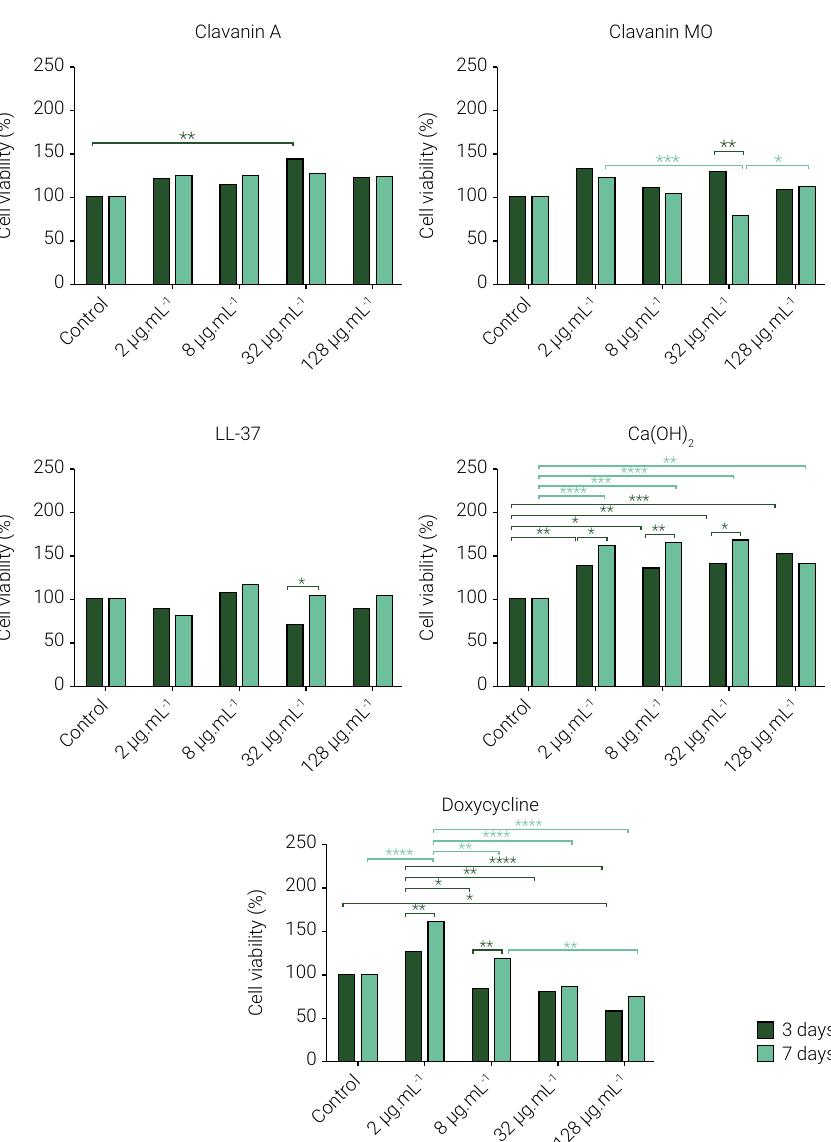
Figure 1. Clavanin A, clavanin MO, LL-37, Ca(OH) and doxycycline cytotoxicity at 2, 8, 32 and 128 μg.mL -1 2 on 2.5x10 3 RAW cells, after 3 and 7 days, by MTT assay. Cultures were stimulated with 100 ng.mL -1 of rRANKL. Cell viability was represented by percentage. Control group was represented by 2.5x10 3 RAW cells stimulated with 100ng.mL -1 of rRANKL and considered 100% of cell viability. All experiments were done in technical and biological triplicates. Statistical differences by two-way ANOVA test and Tukey’s post hoc were represented by *p<0.05, **p<0.005, ***p<0.0005 and ****p<0.0001 compared to each concentration and time tested conditions; Dark green bars represent statistical differences observed on day 3; Light green bars represent statistical differences observed on day